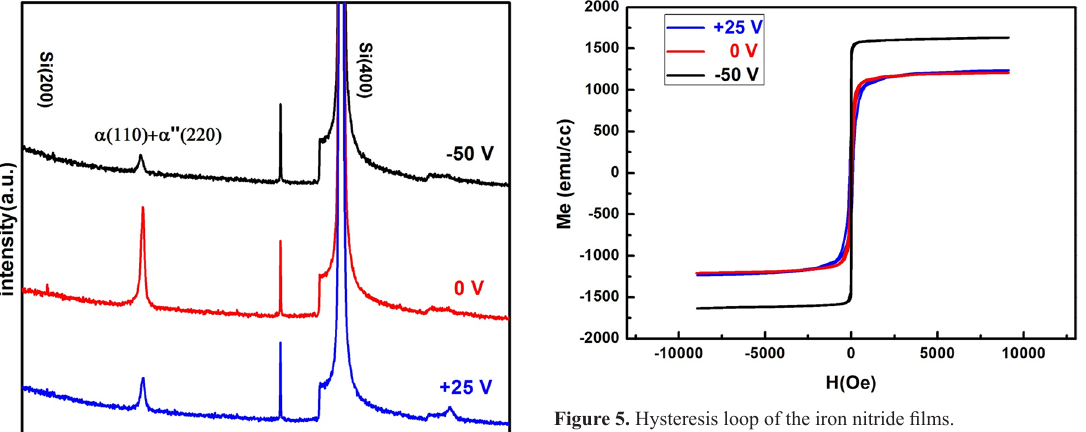
N calculated using 16 2